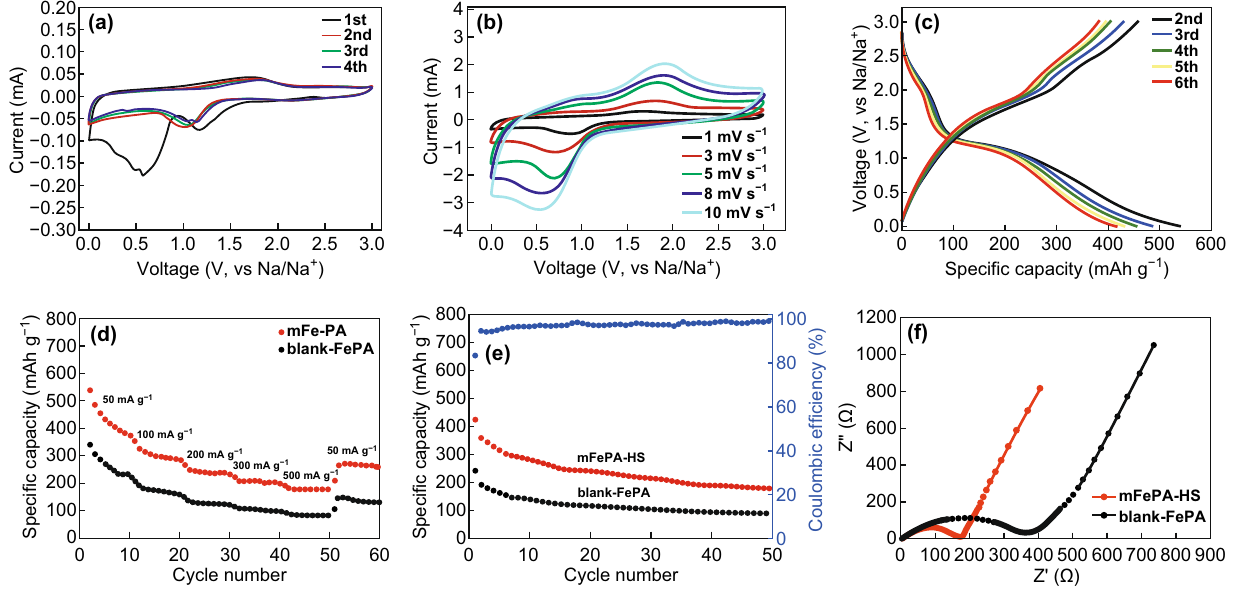
Fig. 5 The electrochemical performance of mFePA-HS and blank-FePA. a Cyclic voltammetry (CV) curves of mFePA-HS. b CV curves of mFePA-HS at different scan rates. c The discharge and charge curves after the initial cycle of mFePA-HS. d The rate capability of mFePA-HS and blank-FePA. e The cycling performance of mFePA-HS and blank-FePA at a current density of 200 mA g −1 . f Nyquist plots of mFePA-HS and blank-FePA at room